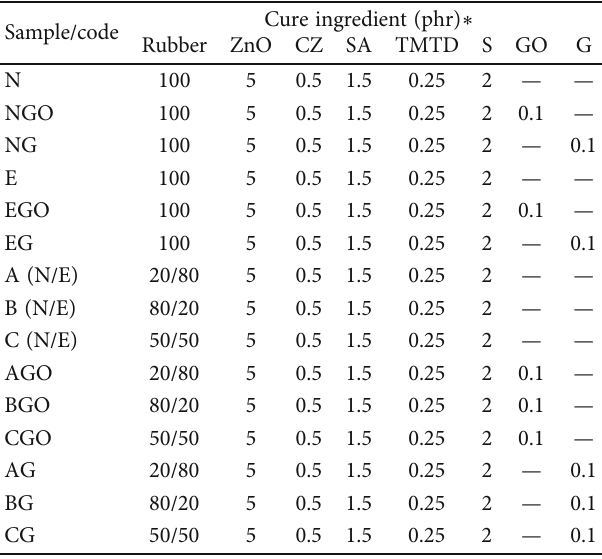
Table 1: Composition of rubber